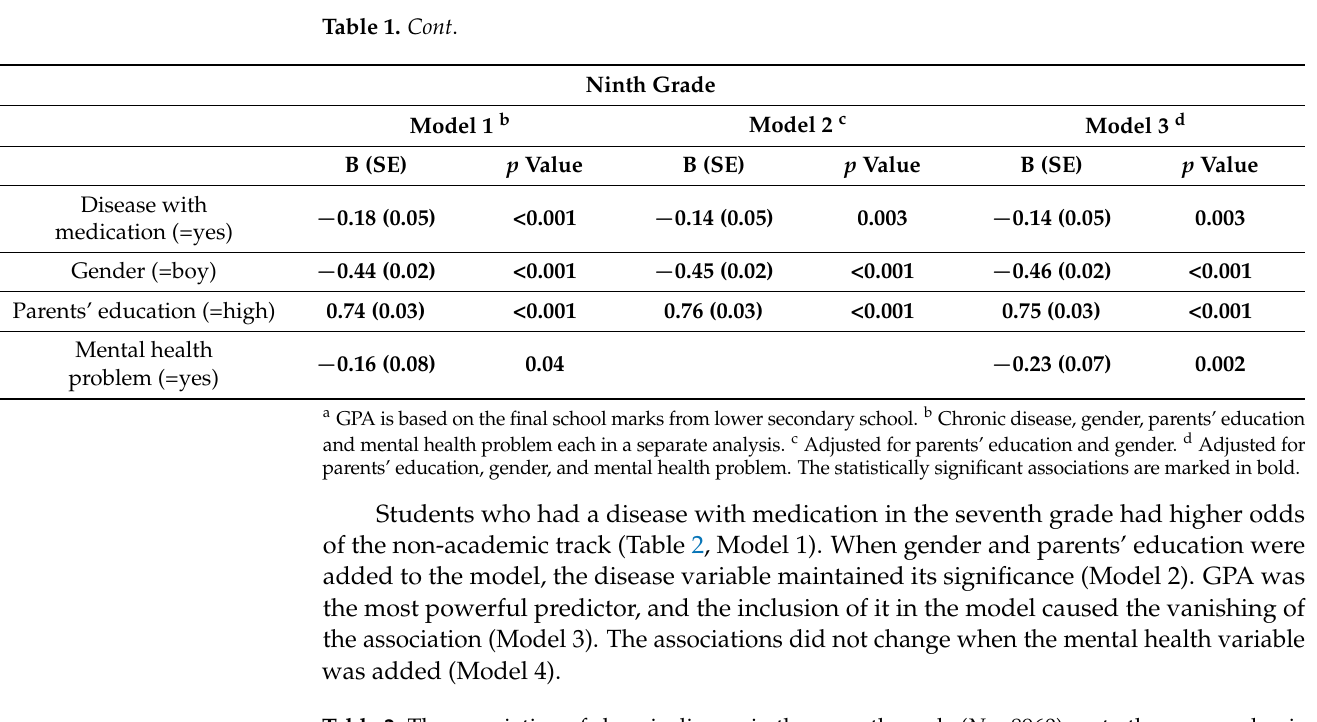
Table 2. The association of chronic disease in the seventh grade ( N = 8960) up to the non-academic upper-secondary school. Bivariate (Model 1) and adjusted logistic regression models (Models 2–4). Odds ratios (OR) and their 95% confidence